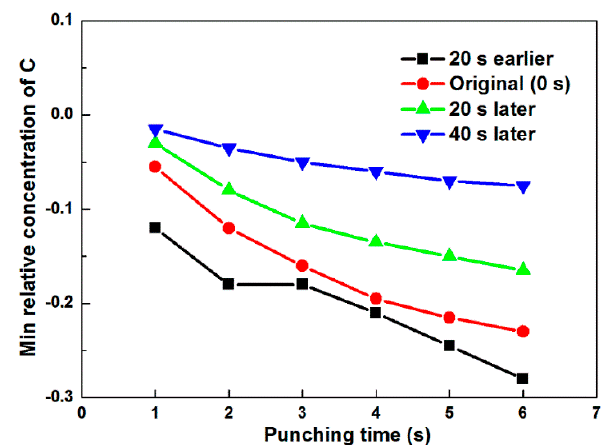
Figure 13. The evolution of the minimum relative concentration of C with time using different punching start times.